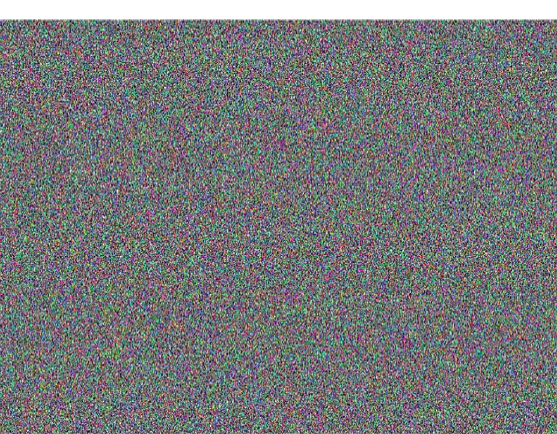
Figure 7: Initial condition perturbation